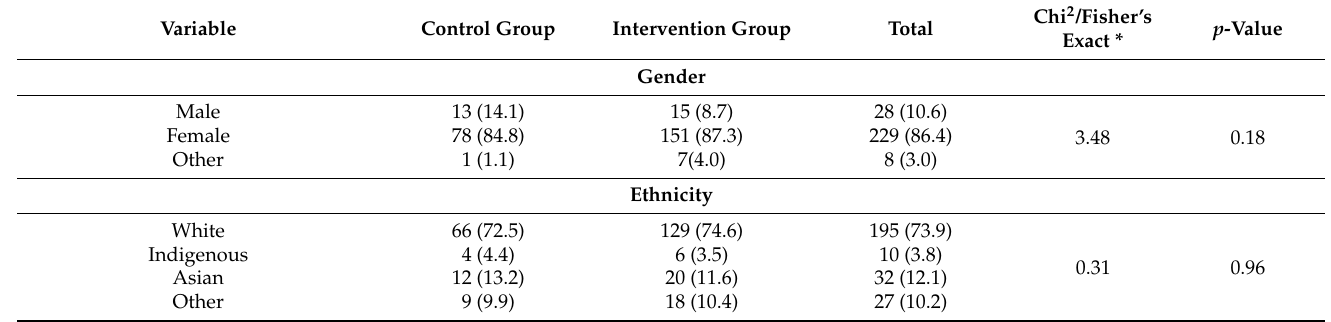
Table 4. Distribution of the demographic characteristics of the youth subscribers across the interven- tion